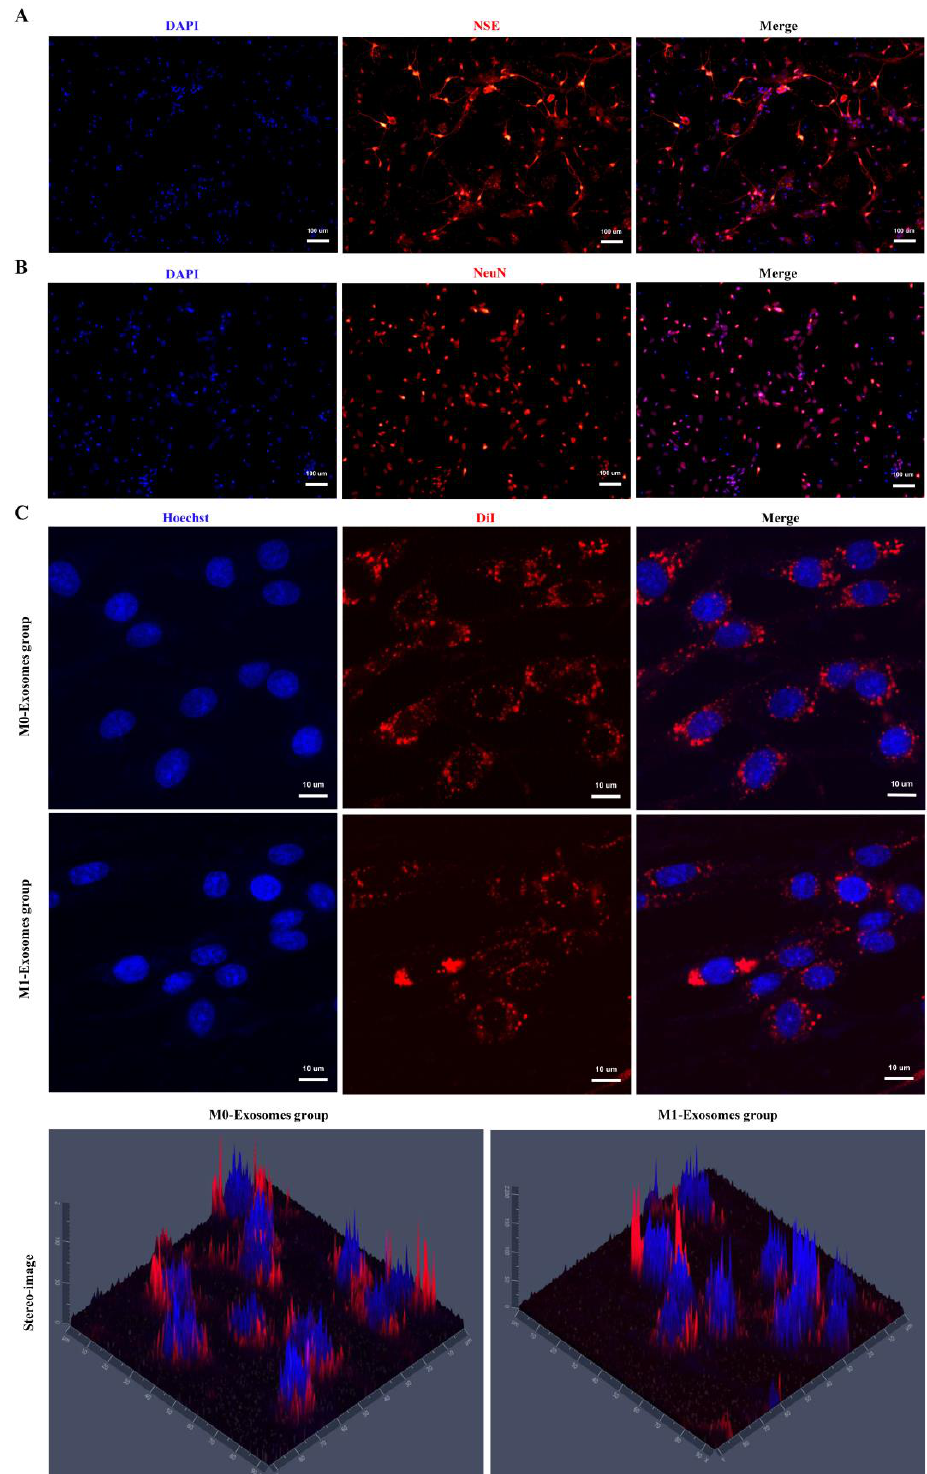
Figure 4. Molecular characterization of primary neuronal cells and the internalization of exosomes. ( A , B ) Immunofluorescence results showing the expression of NSE and NeuN in primary neuronal cells. Scale bars = 100 μm. Neuronal cells were stained with NSE (red) or NeuN (red), and the nuclei were stained with DAPI (blue). ( C ) Representative confocal images of DiI-labeled exosomes taken up by neuronal cells. Scale bars = 10 µ m. M0-BV2 and M1-BV2 exosomes were stained with DiI (red), and the nuclei of neuronal cells were stained with Hoechst